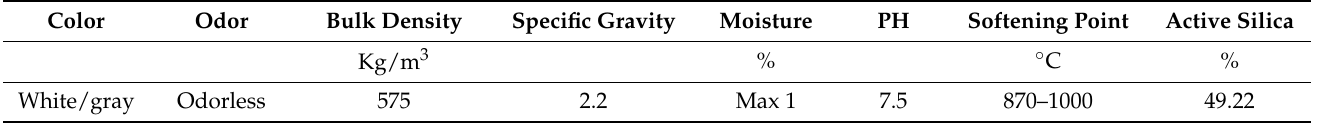
Table 4. Physical properties of perlite.